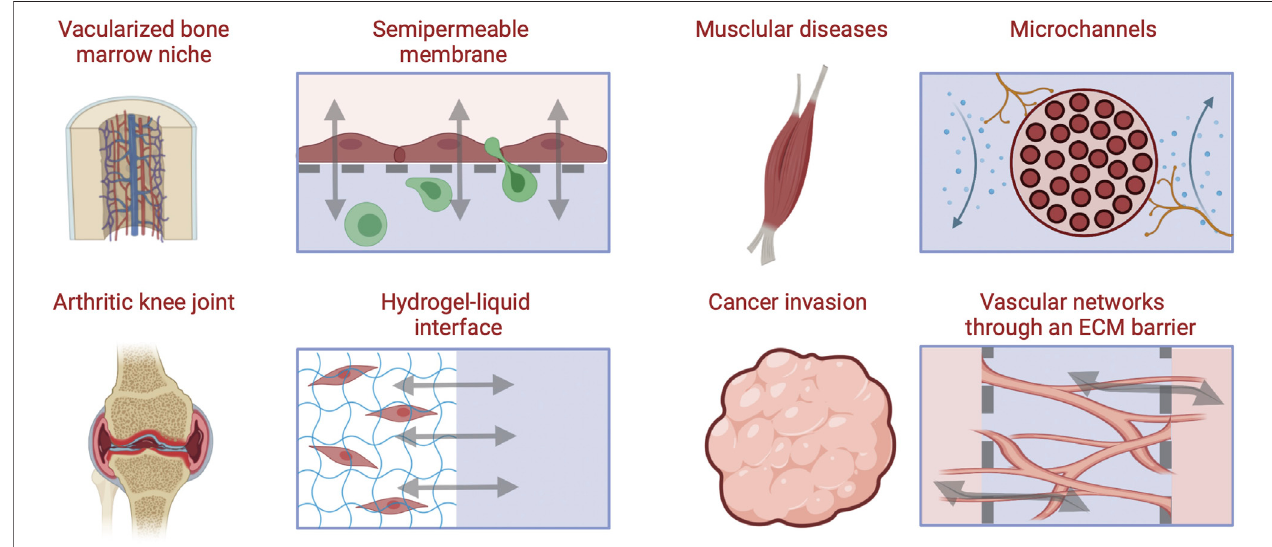
FIGURE 5 | Approaches for engineering barriers and interfaces in musculoskeletal tissues, including porous membrane-based vascular barriers, microchannels, hydrogel-liquid interface, and perfusable microvascular channels network within through an ECM hydrogel barrier [Inspired from (Yeste et al., 2018)].